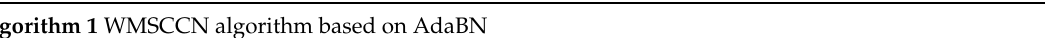
Algorithm 1 WMSCCN algorithm based on AdaBN for neuron i of BN layer in WMSCCN